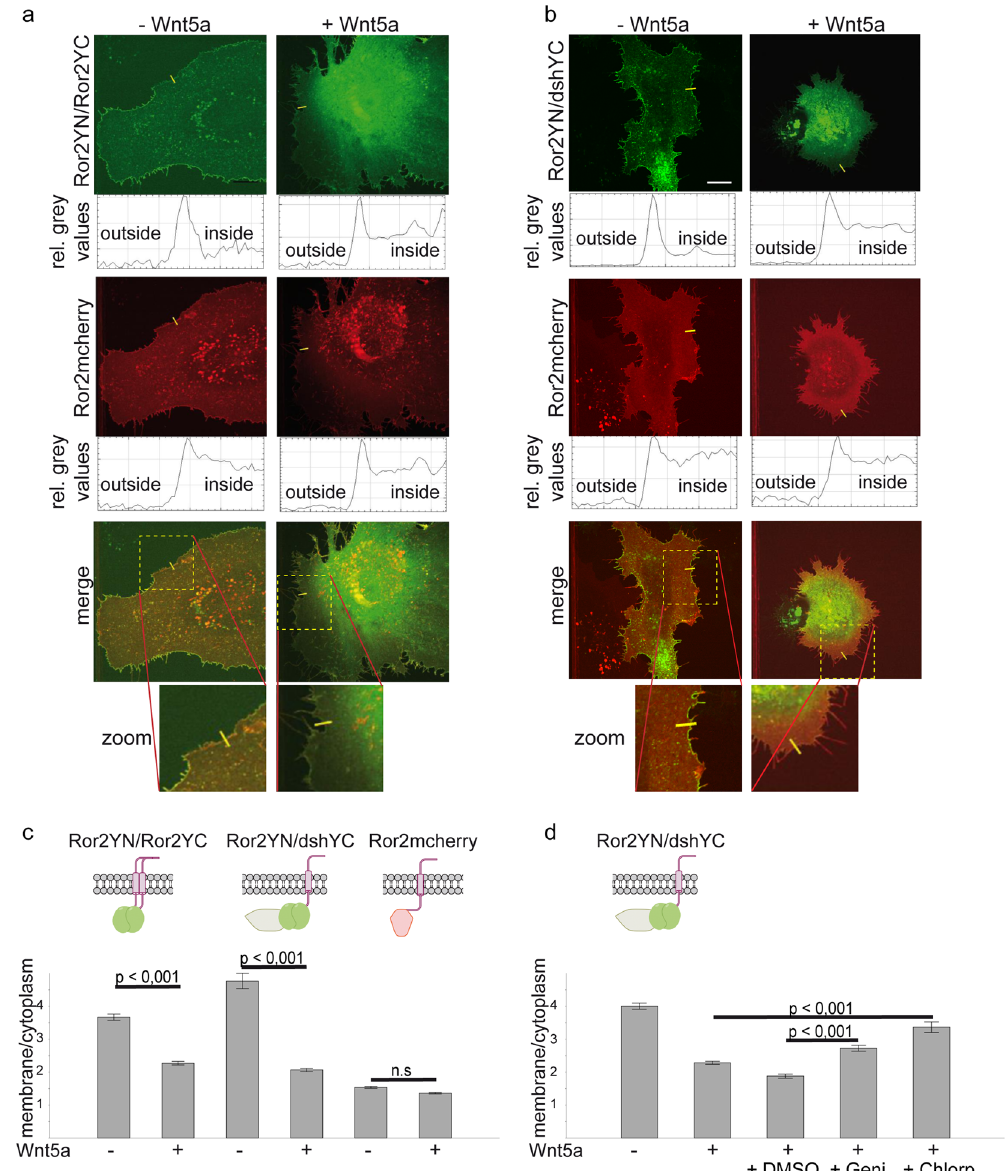
Figure 4. Wnt5a induces redistribution of Ror2 homodimers and Ror2/dsh heterodimers. The subcellular localization of fluorophore tagged Ror2 homodimers ( a ) and Ror2/dsh heterodimers ( b ) was analyzed by a bimolecular fluorescence complementation assay (BiFC) in transiently transfected Xenopus tissue culture cells. The relative grey values show the intensity profiles at the positions marked by yellow bars. ( c , d ) The membrane/ cytoplasm values were calculated in the following way: membrane/cytoplasm = (intensity at the membrane – intensity outside)/(intensity inside – intensity outside). Shown are the mean values and standard errors of at least 399 profiles of more than 60 cells from at least ten independent experiments. Median and dispersion (25–75% range) are shown as box-and-whiskers plots in Supplementary Fig. 5b. ( d ) The effect of endocytosis inhibitors chlorpromazine and genistein on the subcellular distribution of Ror2/dsh heterodimers. Shown are the mean values and standard errors of at least 280 profiles of more than 40 cells in at least seven independent experiments. p values according to Student’s t-test, n.s.: not significant. Median and dispersion are shown in Supplementary Fig.